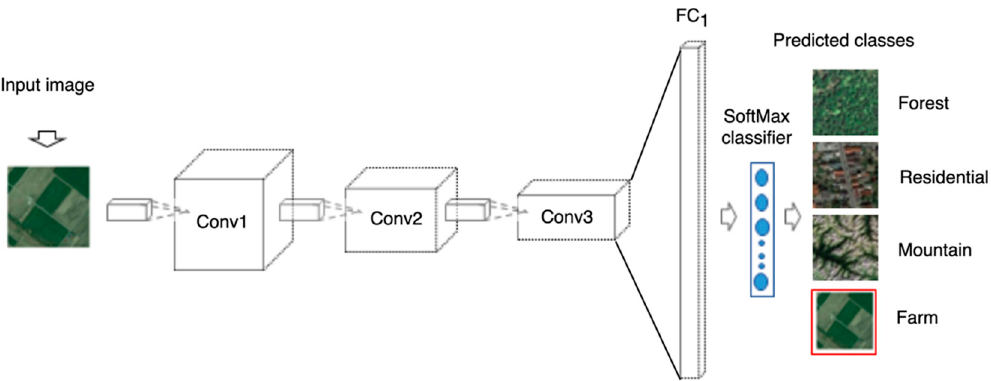
Figure 1. Architecture of a classical convolutional neural network (CNN). The CNN applies convolutional operations, as well as max-pooling, to process input tiles, but no feature concatenation is implemented.